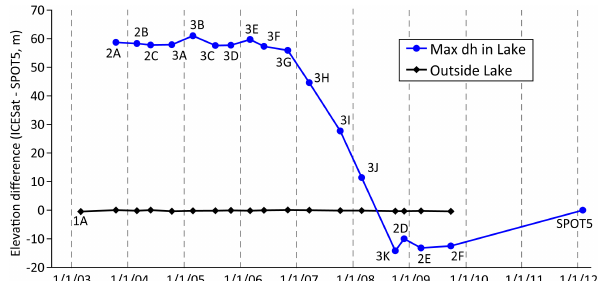
Fig. 5. Time series of elevation difference between the various ICESat laser periods and the 9 February 2012 SPOT5 DEM. In black, the mean elevation difference outside of Lake Cook E2 . In blue, the maximum elevation difference between ICESat and the SPOT5 DEM. Note that, due to non-perfect repetitiveness of ICE- Sat tracks, the blue dots do not correspond to the same location for each laser campaign (Fig. 4b) which partly explains why the noise seems larger within Lake Cook E2 than